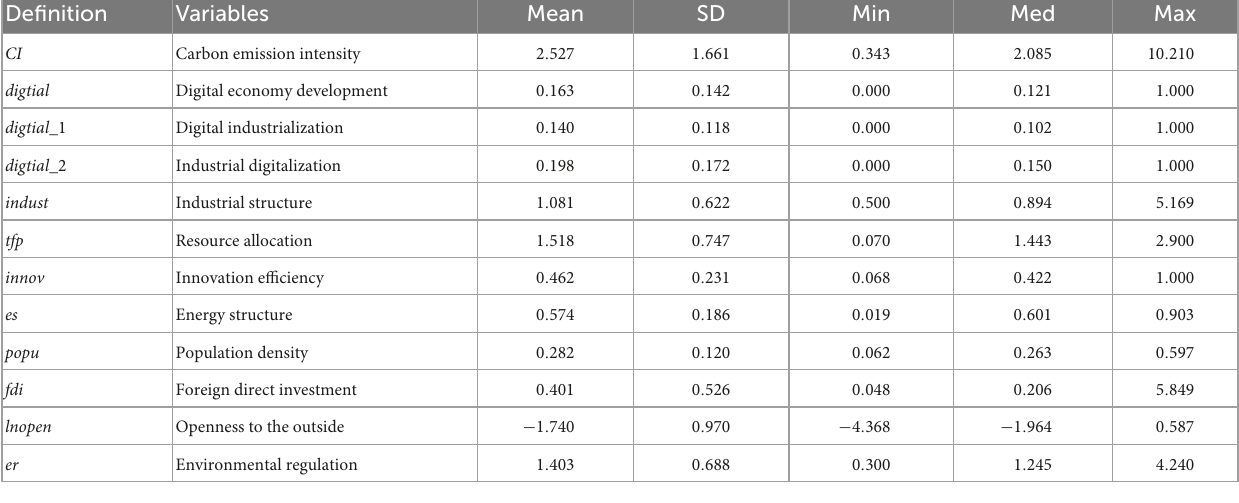
TABLE 4 Descriptive statistics of variables.